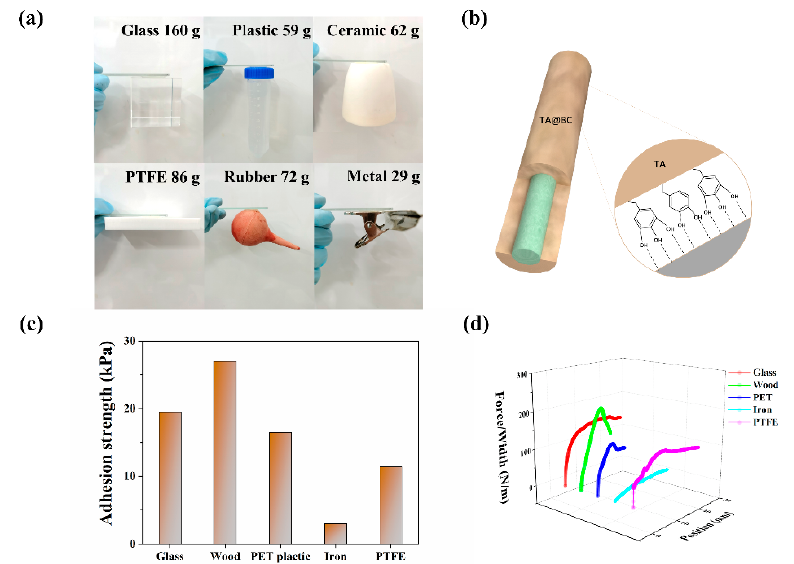
Figure 5. Adhesion properties of the hydrogel. ( a ) Optical images of P(AA-AMPS)-TA@BC 0.5 -Ca 2+ hydrogel adhesion to different substrate materials; ( b ) schematic illustrations of the adhesion mechanism; ( c ) tensile adhesion strength of P(AA-AMPS)-TA@BC 0.5 -Ca 2+ hydrogel to different matrix materials; ( d ) adhesion energy of P(AA-AMPS)-TA@BC 0.5 -Ca 2+ hydrogel on different matrix materials.